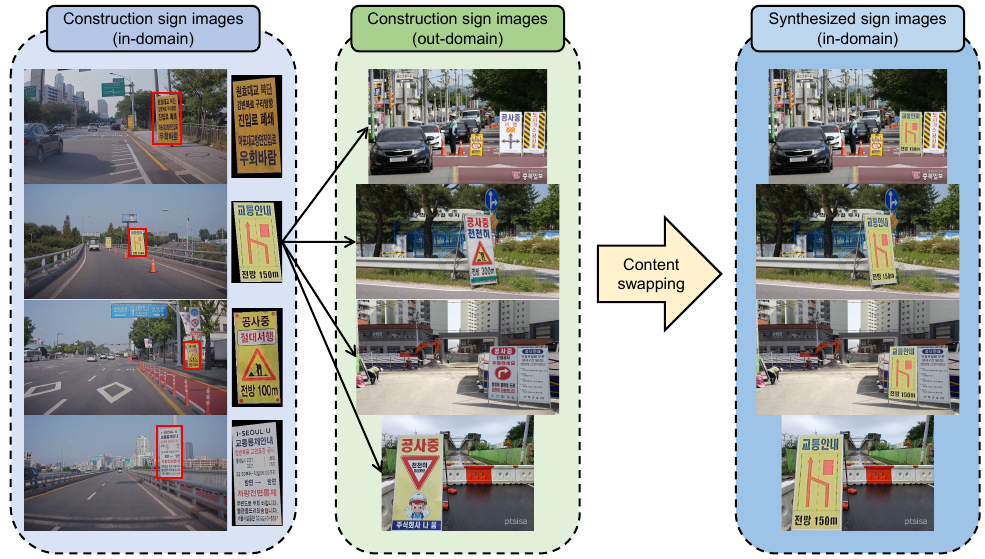
Figure 1. Content swapping. With N I in-domain and N O out-domain construction sign images, we synthesize N I N O in-domain construction sign images via perspective transformation. The synthe- sized sign images are used as source images for